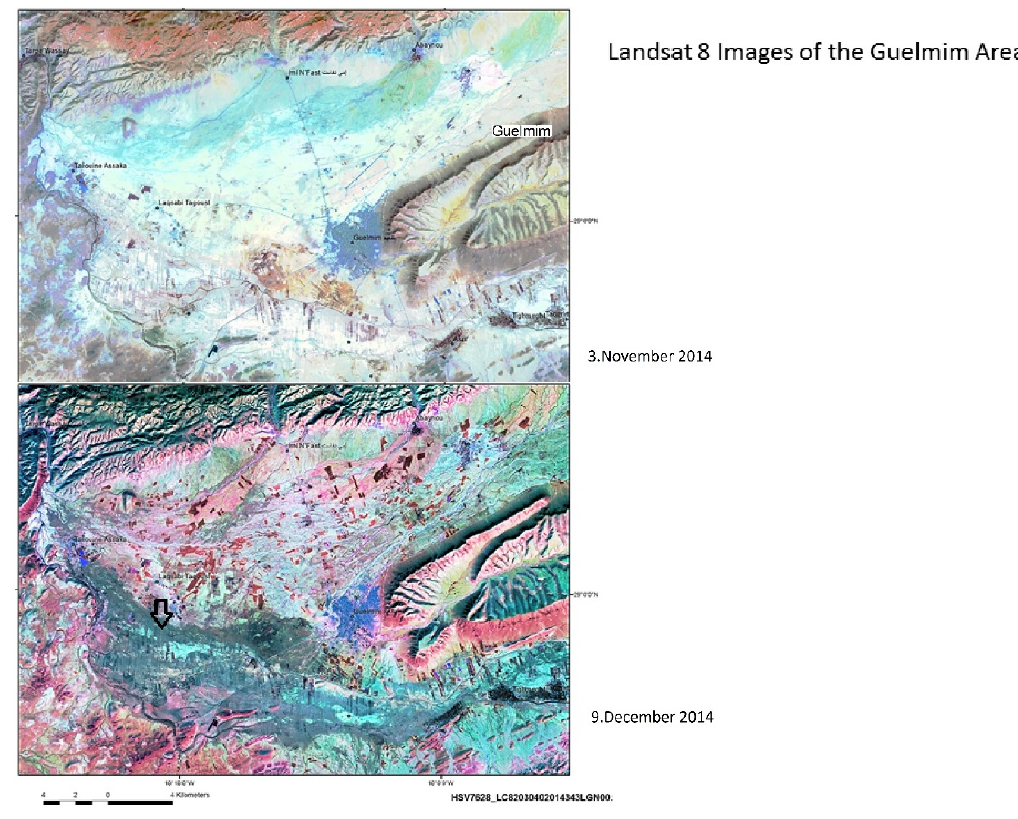
Figure 11. Comparison of the Landsat 8 RGB images (Bands 7, 6, 2 + 8) from 3 November 2014 and 9 December 2014. The almost recent sediments are visible in green colors on the image after the November 2014 flash floods (lower